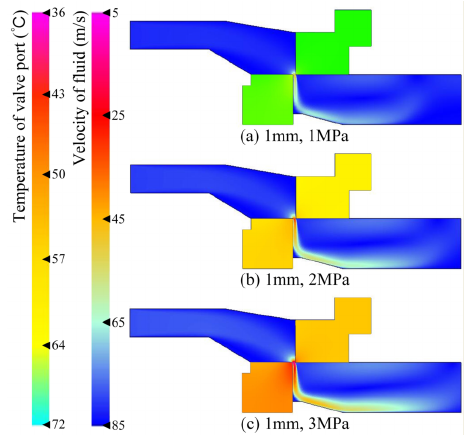
Figure 14. Temperature field of the valve orifice and fluid velocity at different inlet pressures, valve opening of 1 mm with time at 60 min .